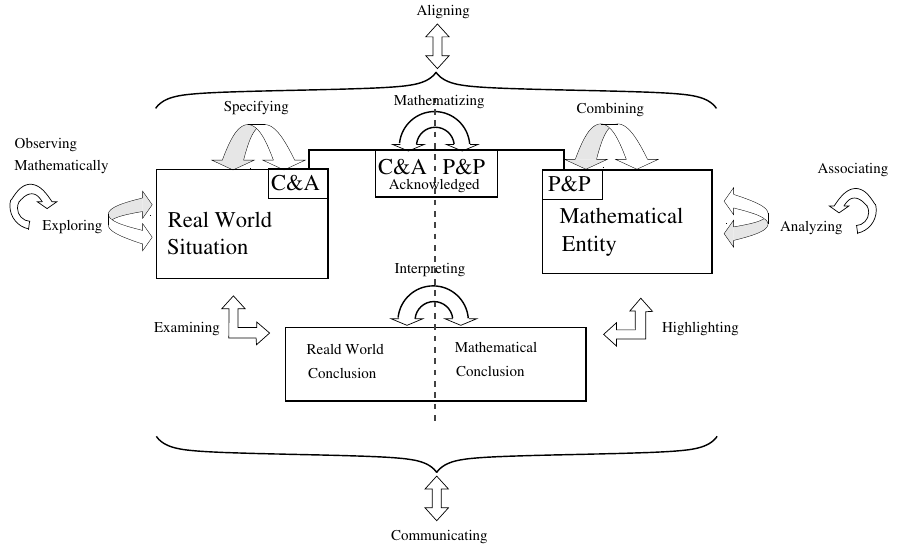
Figure 4. A diagram for the mathematical modeling cycle introduced in [147] and cited in [9]. The notations C&A and C&A are used for “conditions and assumptions” and “properties and parameters”,